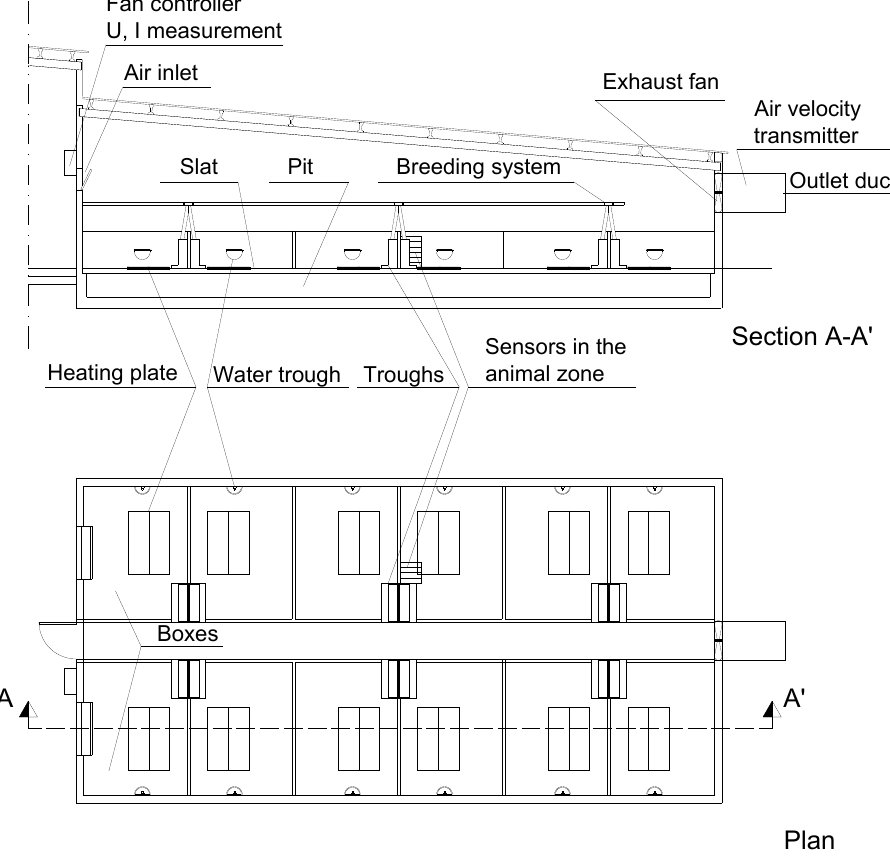
Figure 1. Postweaning room and location of sensors.